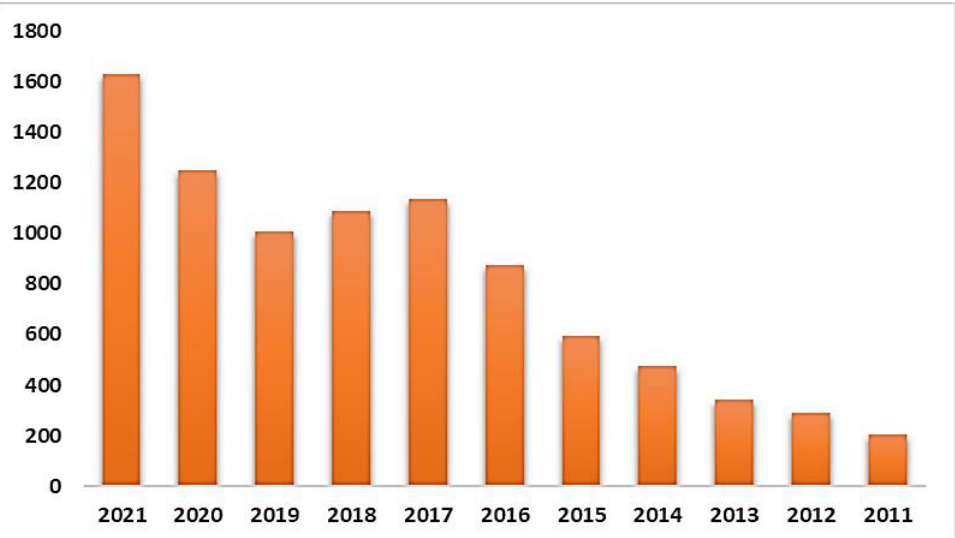
Figure 1. Schematic diagram of published articles in the Web of Science concerning with nanofluids.